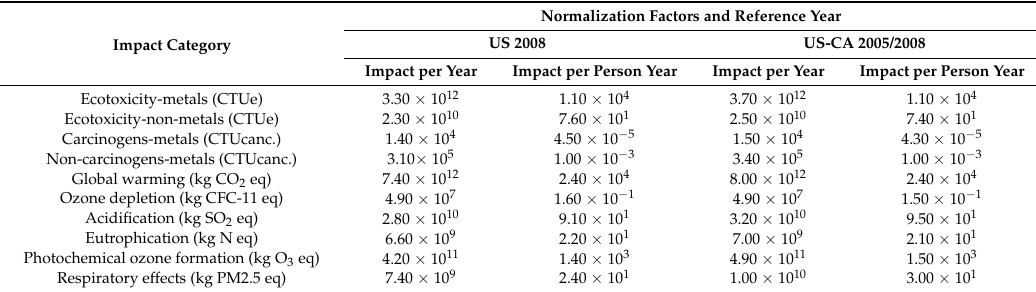
Table 3. Normalization factors for impact categories based on inventories from the US (2008) and US-Canada [45].